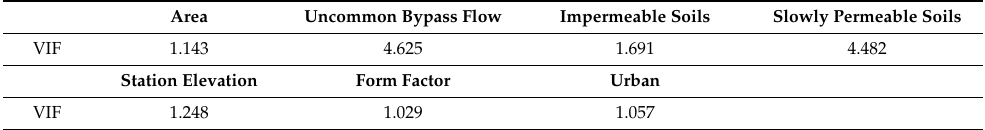
Table 3. VIF values of the explanatory variables kept in the parsimonious RDA model. VIF values exceeding 10 indicate collinearity between variables.